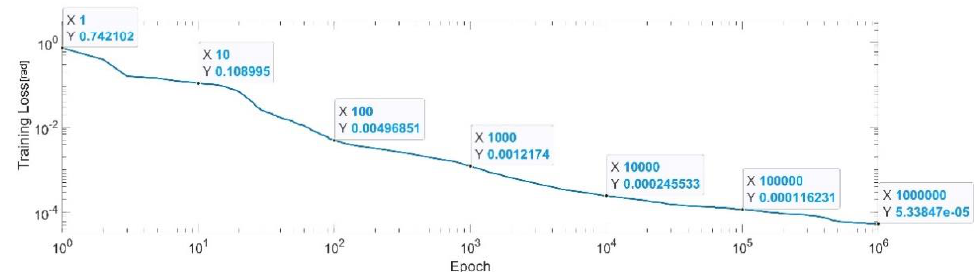
Figure 27. Convergence of the neural network for the first generalized coordinate 𝑞 6 (log scale).